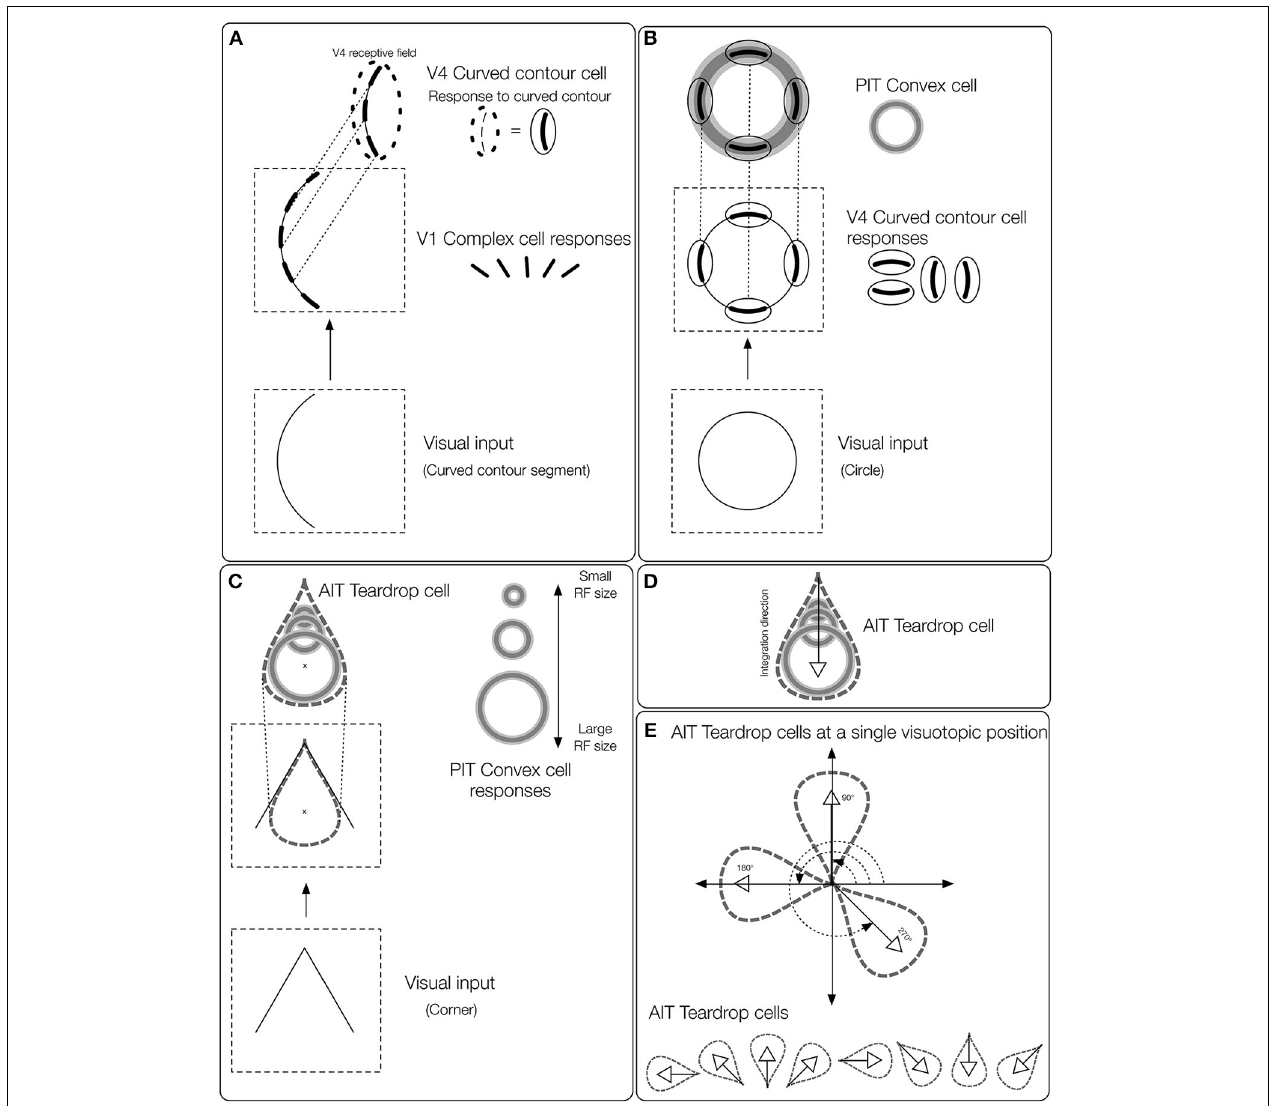
FIGURE 2 | Overview of the teardrop model stages. Network layers are labeled (e.g., V4, PIT, etc.) according to where the computations are proposed to take place in the primate visual system. The input to the model is a preprocessed edge map of the visual display, similar to the output of V1 complex cells. (A) The first model stage contains cells selective to curved contours ( curved contour cells ). When a curved segment enters the RF (bottom panel), curved contour cells group the piecewise linear spatial pattern of complex cell outputs (middle panel) to approximate a curved segment (top panel). The dashed ellipse signifies the curved contour cell RF, which hereafter is represented by a curved segment embedded inside a solid ellipse. (B) Convex cells in model PIT receive input from curved contour cells in an on-surround/annular spatial arrangement. Convex cells respond optimally to circles (bottom panel), because curved contour cell responses to the circular boundary contours